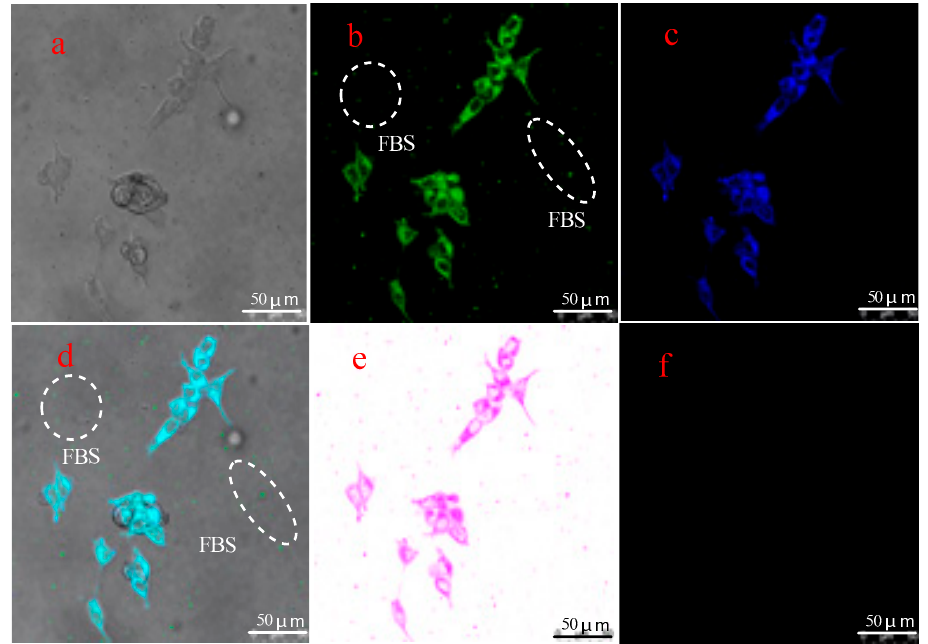
Figure 4. Fluorescence images of the stained protein FBS in culture medium and the HEC-1A cells: ( a ) bright-field; ( b ) the stained BSA and HEC-1A cells with ESIPT-F; ( c ) the stained BSA and HEC-1A cells with DAPI; ( d ) the overlay of b and c; ( e ) reverse color of b; ( f ) dark fields.